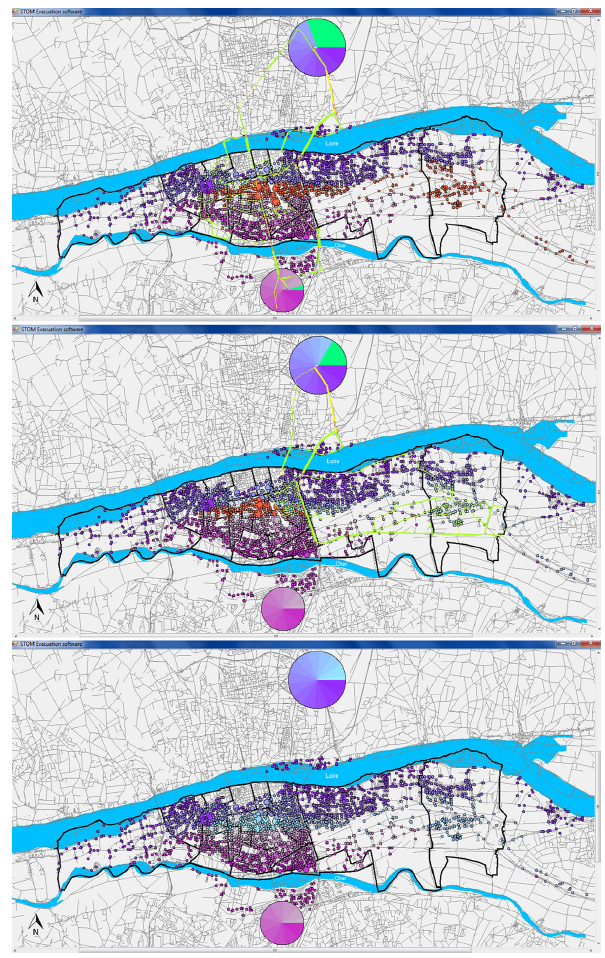
Figure 11. Evacuation scheduling of the Tours valley. Each subfig- ure shows the evacuated buildings and the paths taken during the slot